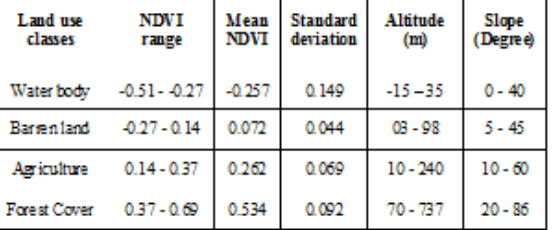
open land, 0.14 to 0.37 for agriculture and 0.37 to 0.69 for the forest cover. The most of the healthy vegetation cover is found in the altitude from 70-750 m on the sloppy area of 20- 86 degrees.